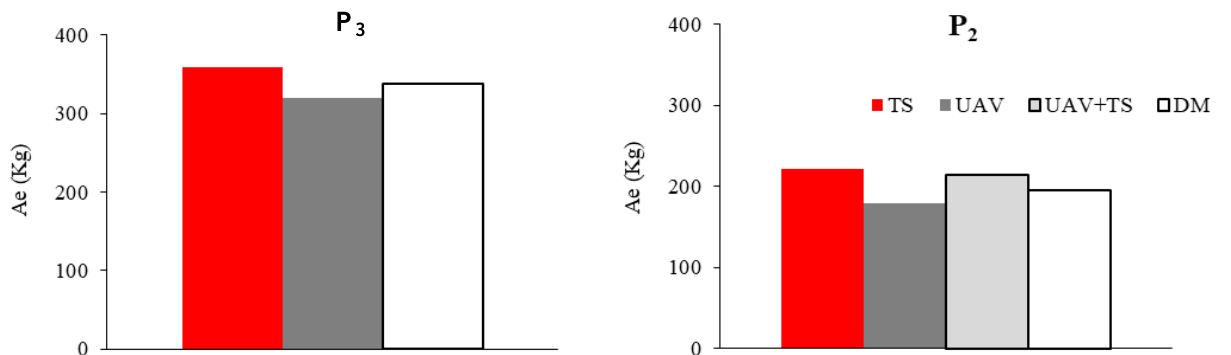
Figure 19. Comparison among the plot soil loss values measured by the different survey methods for the P3 (22 m × 6 m, s = 26%) and P2 (22 m × 6 m, s = 22%) plots (modified from [67]).